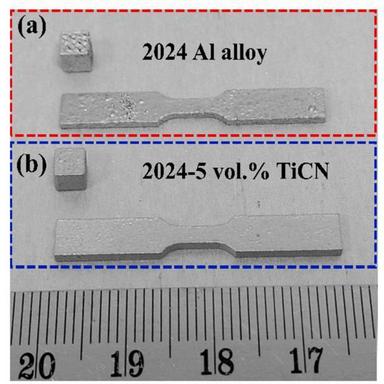
The LPBFed (a) pure 2024 Al alloy and (b) 2024-5 vol% TiCN composite samples.